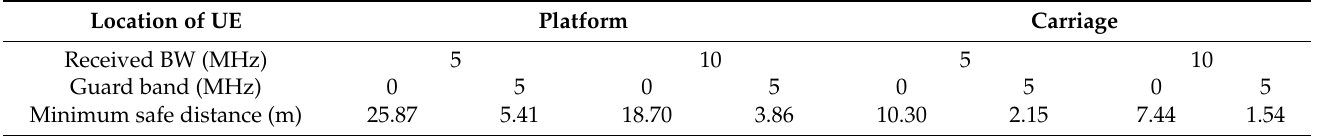
Table 4. LTE FDD UE interfering with LTE-M BS.